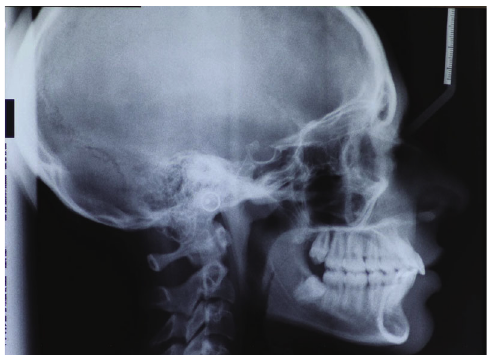
Figure 18: Final panoramic. Figure 19: Final